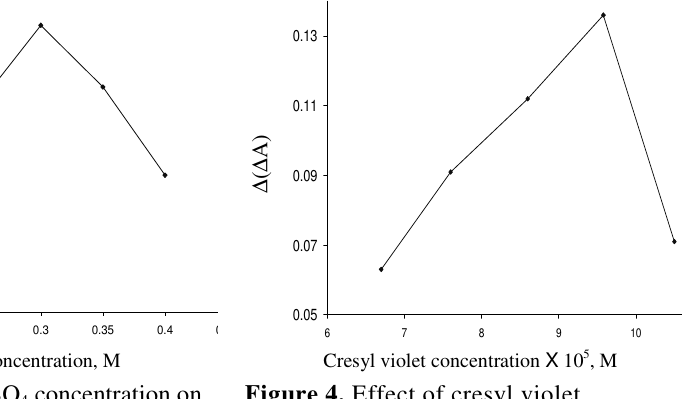
Figure 3. Effect of H Figure 4. Effect of cresyl violet SO concentration on 2 4 the analytical signal. concentration on the analytical signal. Conditions: H 2 SO 4 , 0.3 M; BrO 3− , 2.4 ×10 −3 M, Formaldehyde 40 µ g/mL, Temperature, 27 °C and Time of 2.0 min from initiation of the reaction.